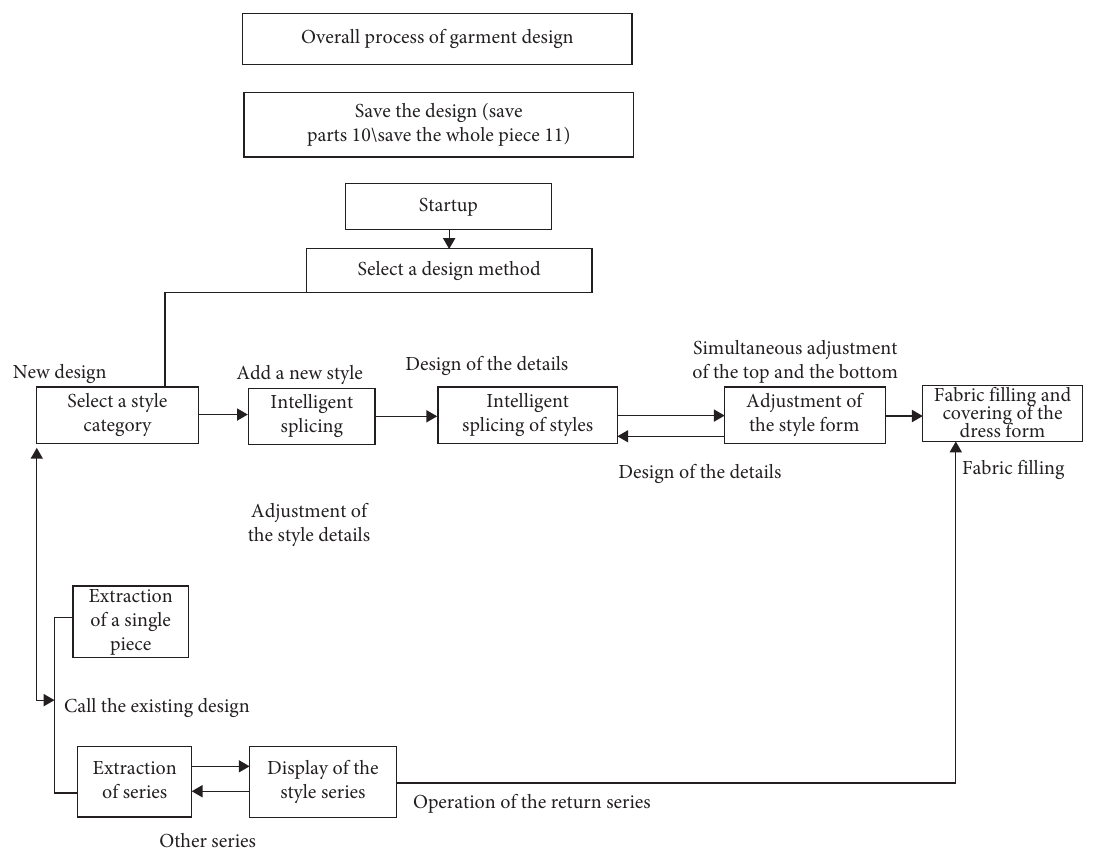
Figure 4: User module design